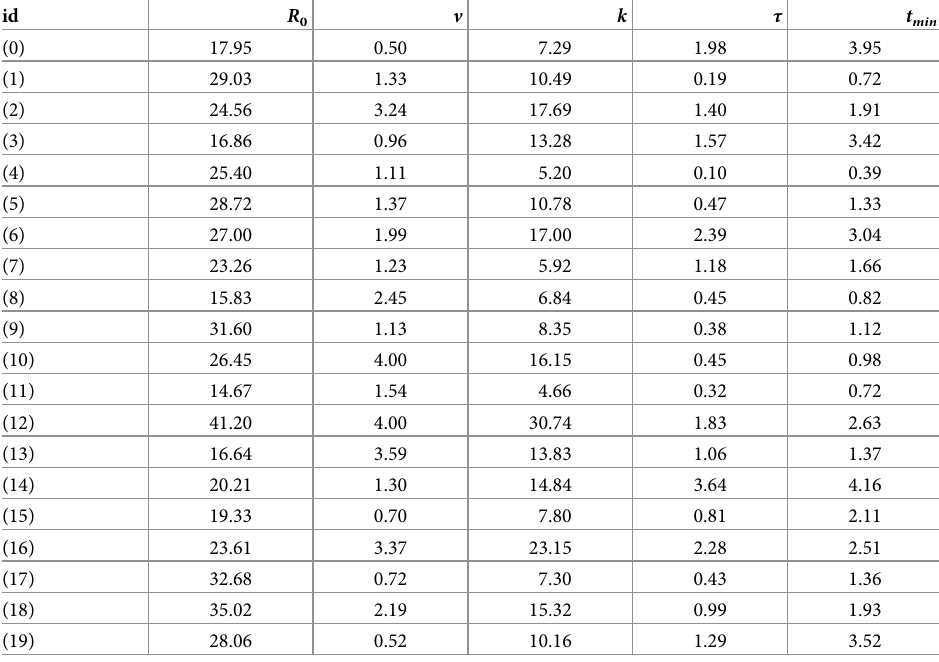
Table 1. Parameters of the least-square solutions of Eq (5) corresponding to the fits shown on Fig 2. The first col- umns represents the patients’ ID, ( R 0 , v , k , τ ) are the estimated parameters of the model, and the regrowth time ( t min ) is derived from them. Lengths ( R 0 , k ) are expressed in mm and times ( τ , t